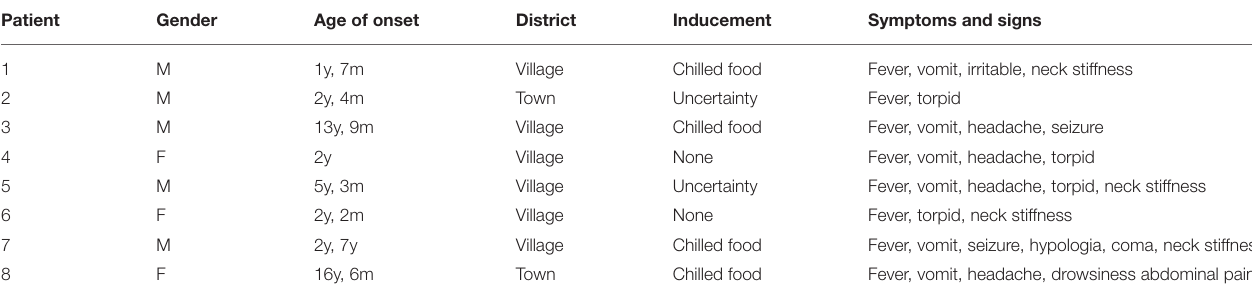
TABLE 1 | The clinical characteristics of the immunocompetent children with LMM in this study. Patient